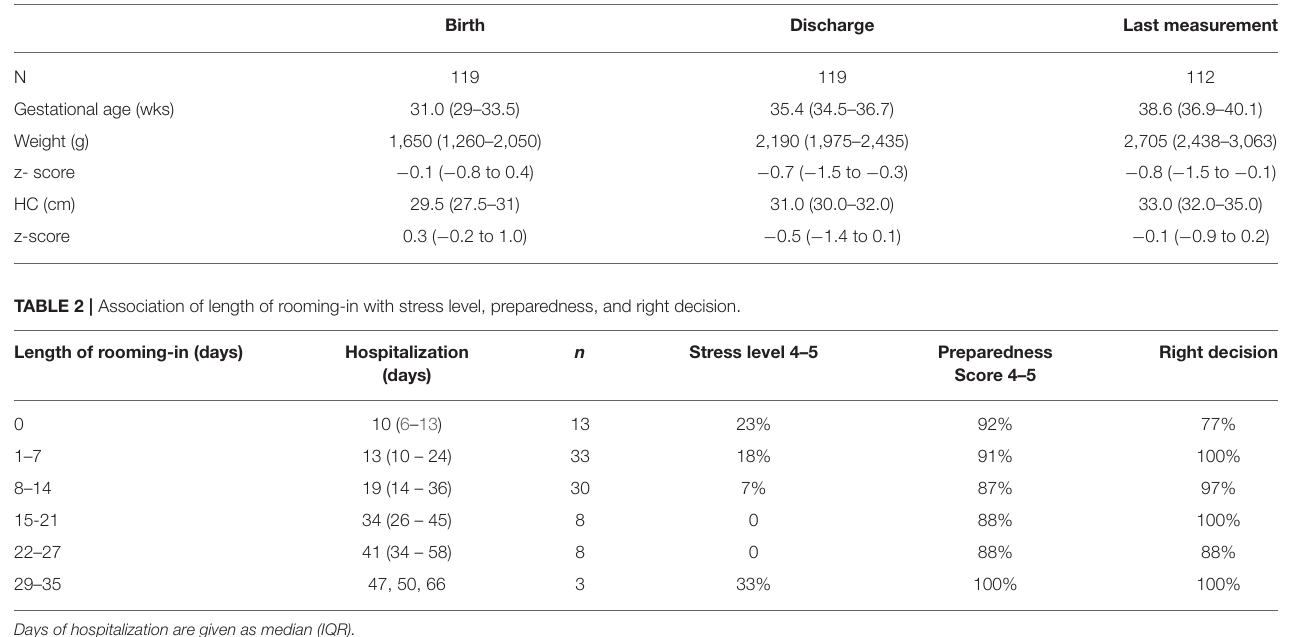
TABLE 1 | Clinical characteristics data is given as median (interquartile range).